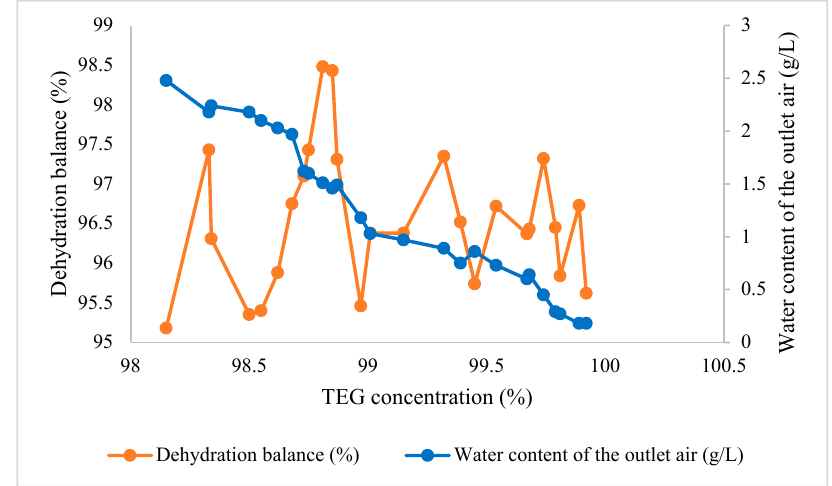
Figure 8. Effect of gas flow rate on dew point. Figure 8. E ff ect of gas flow rate on dew